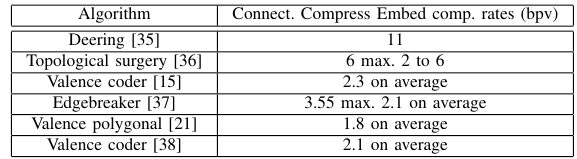
Table I: Compression Rate in BPV of the main single rate mesh compression algorithms (extracted from [25])